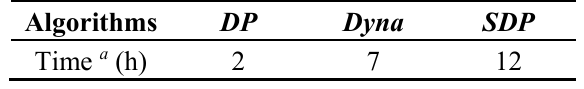
Table 5. Computation times of the Dyna algorithm, SDP, and